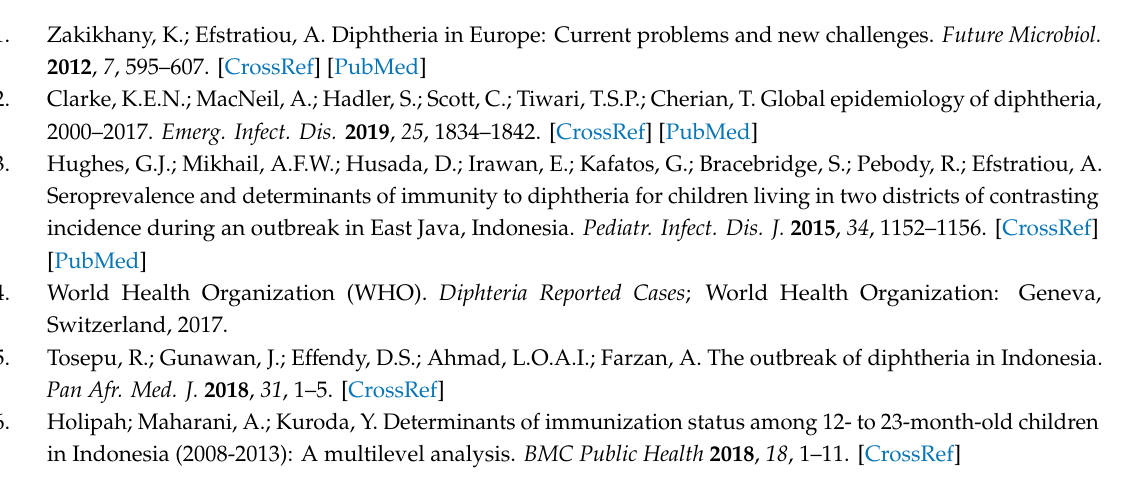
Figure S1: Children’s DTP3 immunization coverage by year, Table S1: Descriptive statistics on household and district